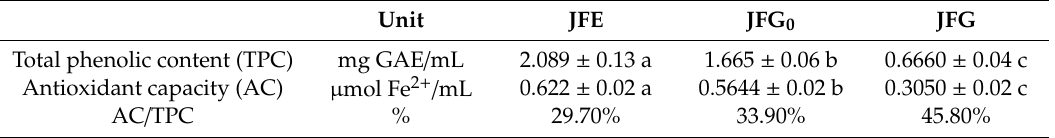
Table 1. Total phenolic content (TPC), antioxidant capacity (AC), and ratio of antioxidant capacity per total phenolic content (AC / TPC) of extract and digesta of Jackfruit